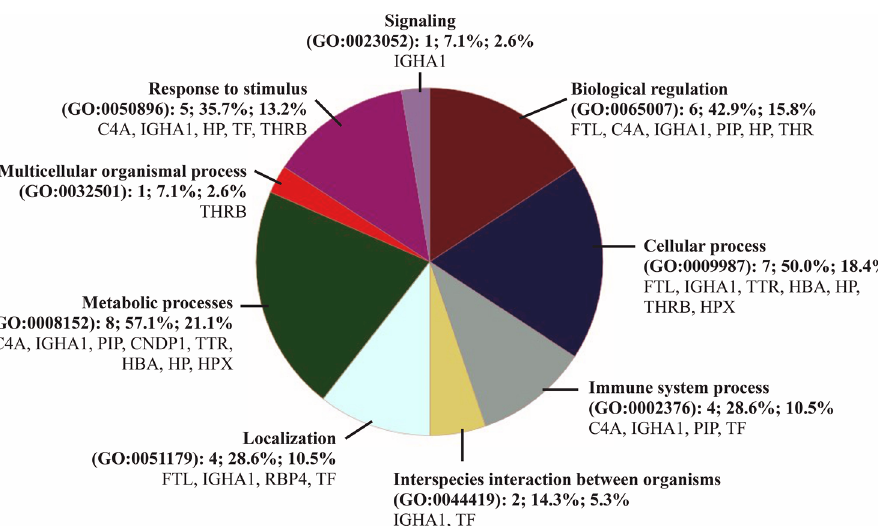
Figure 3. Pie chart representation of Gene Ontology (GO) for identified proteins and summarized according to biological process. Classification is done using proteins identified in Table S2. Chart includes Category name (Accession): # genes; Percent of gene hit against total # genes; Percent of gene hit against total # Process hits; Gene list for each category. FTL: ferritin light chain; HP: haptoglobin; HBA: hemoglobin subunit alpha; RBP4: retinol-binding protein 4; PLG: plasminogen; IGHA1: immunoglobulin heavy constant alpha 1; TTR: transthyretin; PIP: prolactin-inducible protein; CNDP1: beta-ala-his dipeptidase; APOH: beta-2-glycoprotein 1; TF: serotransferrin; C4A: complement C4A; THRB: prothrombin; HPX: hemopexin; C7: complement